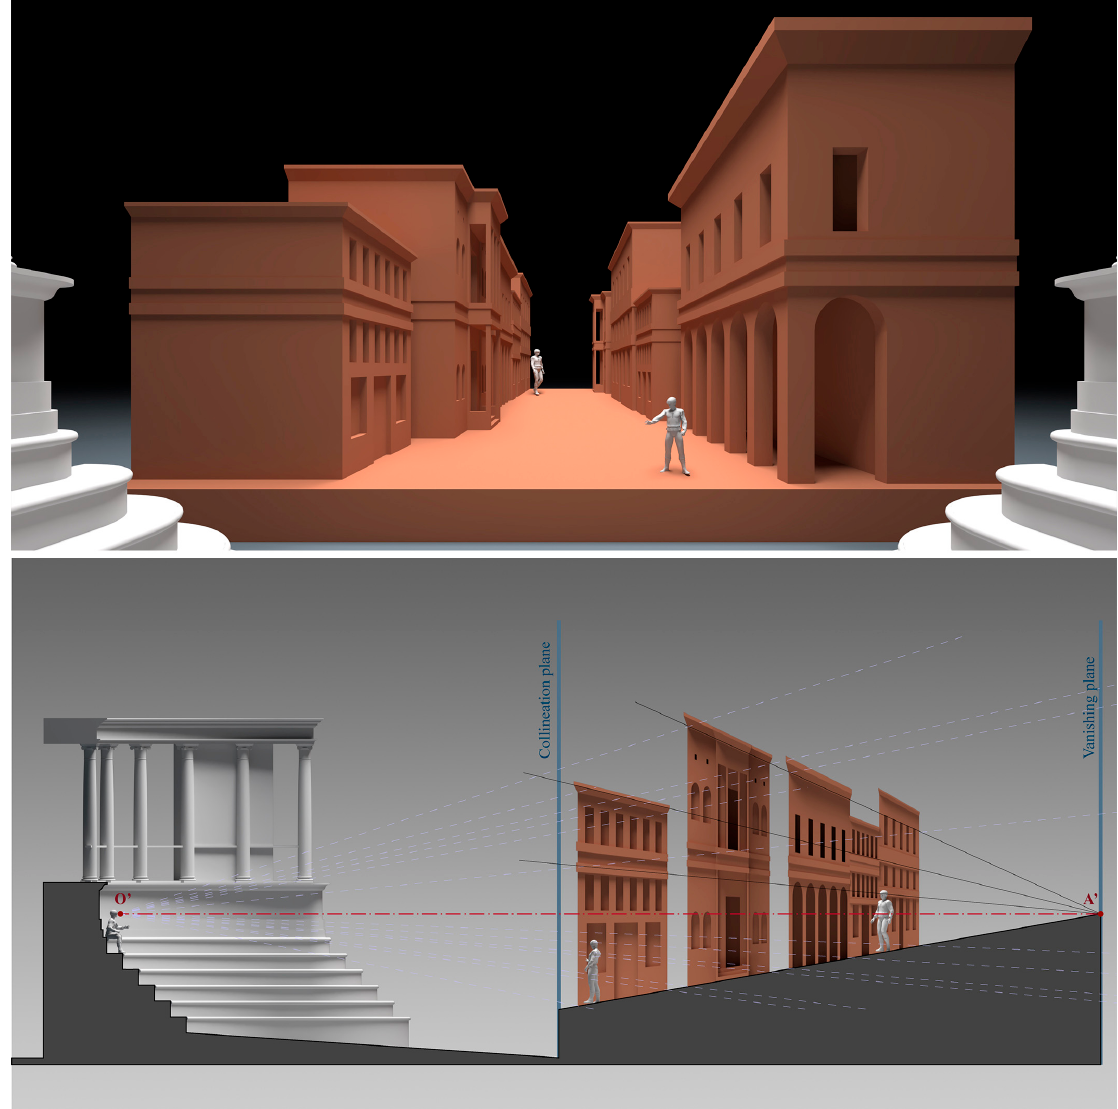
Figure 8. The human figure and the measure of solid prospective